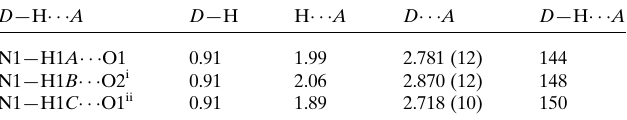
Symmetry codes: (i) x þ 1 ; y ; z ; (ii) (cid:3) x þ 1 ; (cid:3) y þ 1 ; (cid:3) z . Table 7 Hydrogen-bond geometry (A˚ , (cid:5) ) for